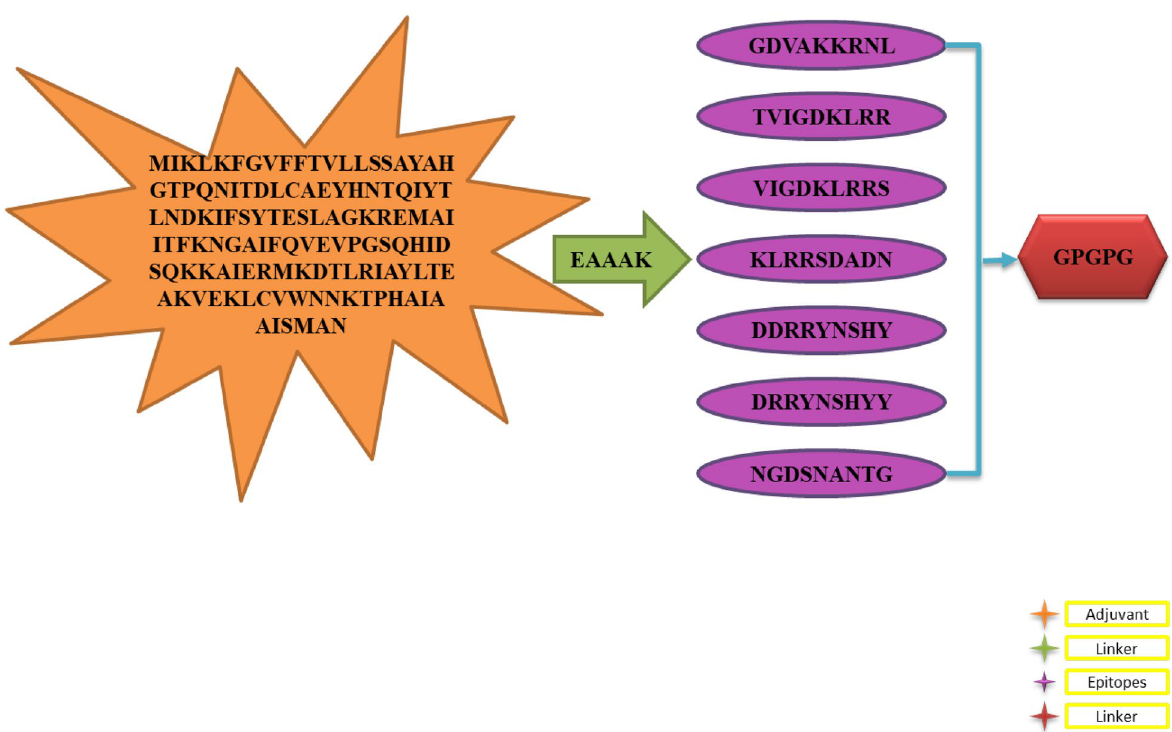
Figure 5. Illustration of the design of the multi-epitope vaccine